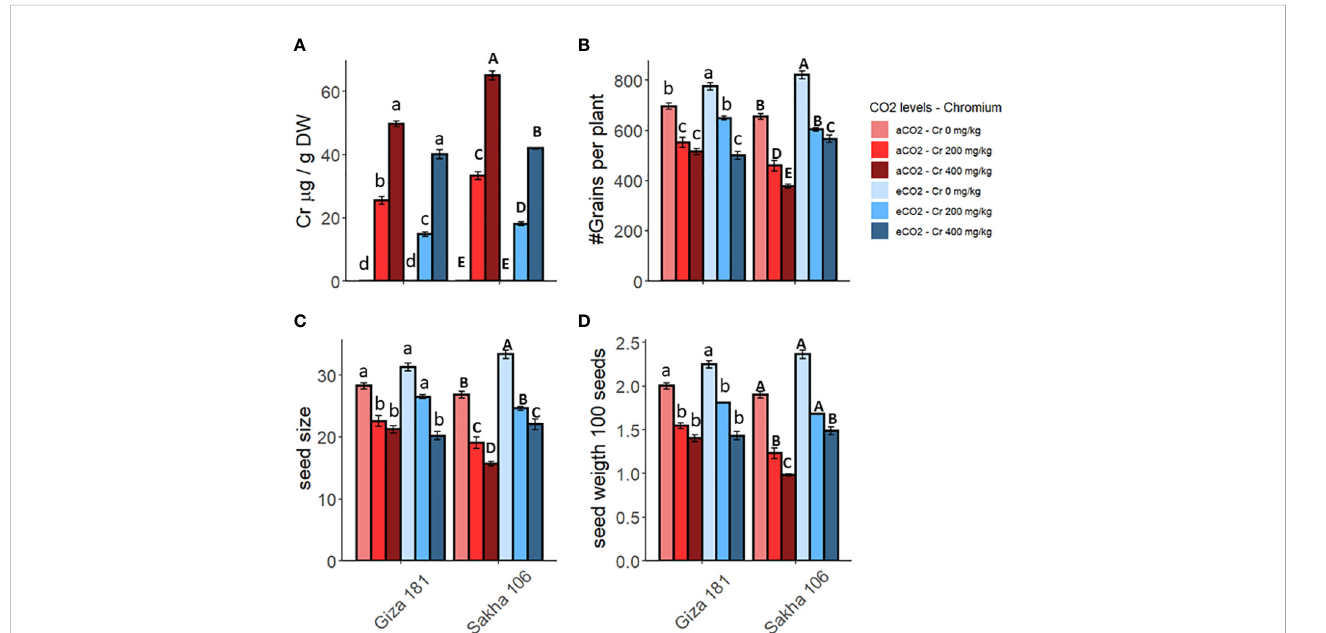
FIGURE 2 Effect of Chromium (Cr) exposure on Cr accumulation (A) and yield parameters (B – D) of rice grains produced under either aCO2 (410 ppm) or eCO2 (620 ppm). Values are presented as means ± standard error of 4 independent replicates. Different letters within the same cultivar represent signi fi cant differences between means (Tukey's Test; P <